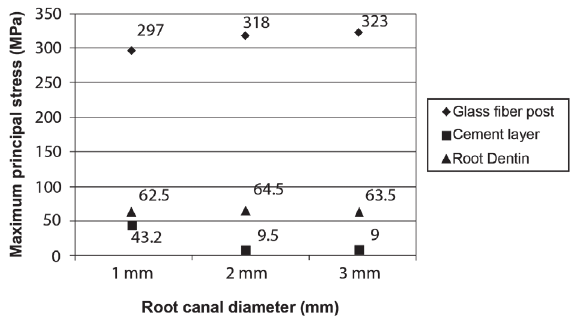
Figure 3- Finite element mesh of the teeth structures. Root dentin (left); Cement line (middle); Glass fiber post (right)